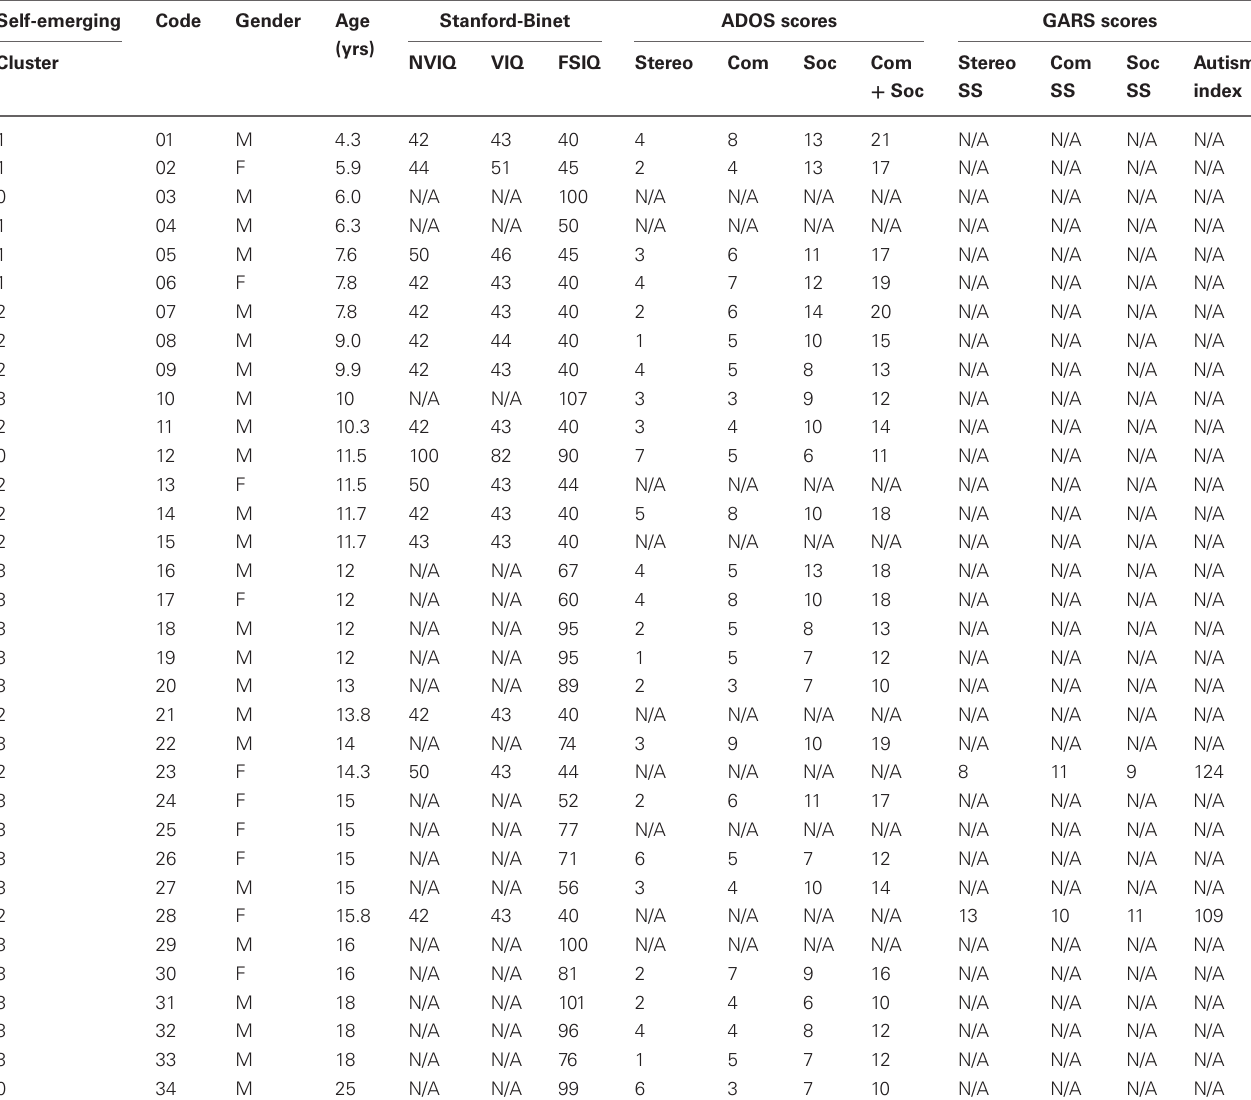
Table A1 | Scores from clinical assessments of the participants with ASD.